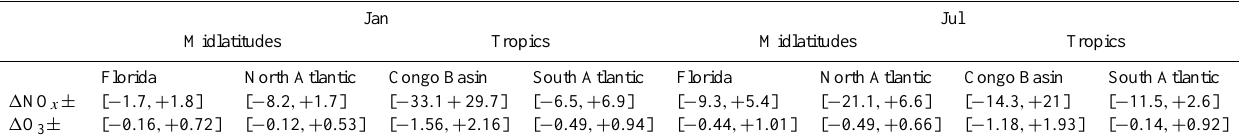
Table 7. The sensitivity of NO x (in ppt) and O 3 (in ppb) depending on β 1 and β 2 values for the midlatitudes (Florida and North Atlantic) and tropics (Congo Basin and South Atlantic) in January and July. Experiment P1, using D h = 15m 2 s − 1 and NO mean GEOS-Chem model. Jan